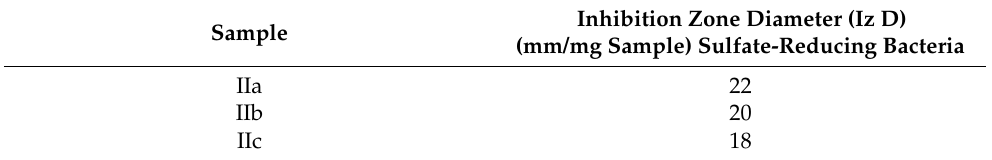
Table 2. Inhibition zone diameter (mm/mg sample) for the synthesized cationic surfactants against sulfate-reducing